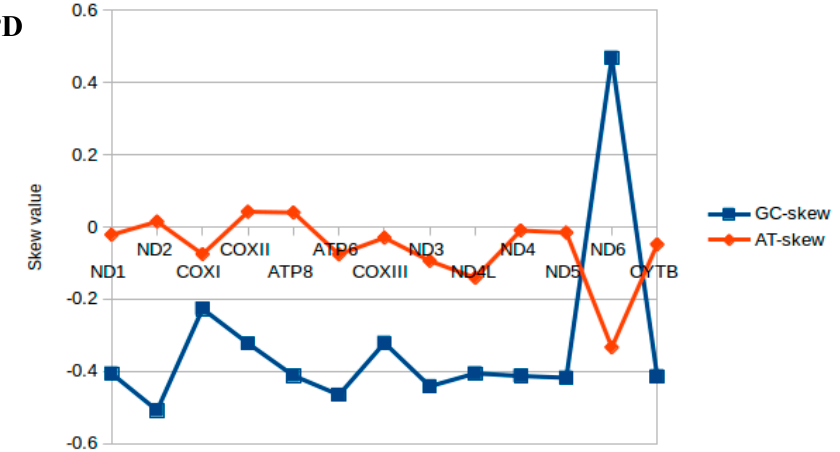
Figure 2. Graphical illustration showing the AT- and GC-skew in the PCGs of the mitochondrial genome of A. amoyensis (AA), N. coibor (NC), and P. diacanthus (PD).